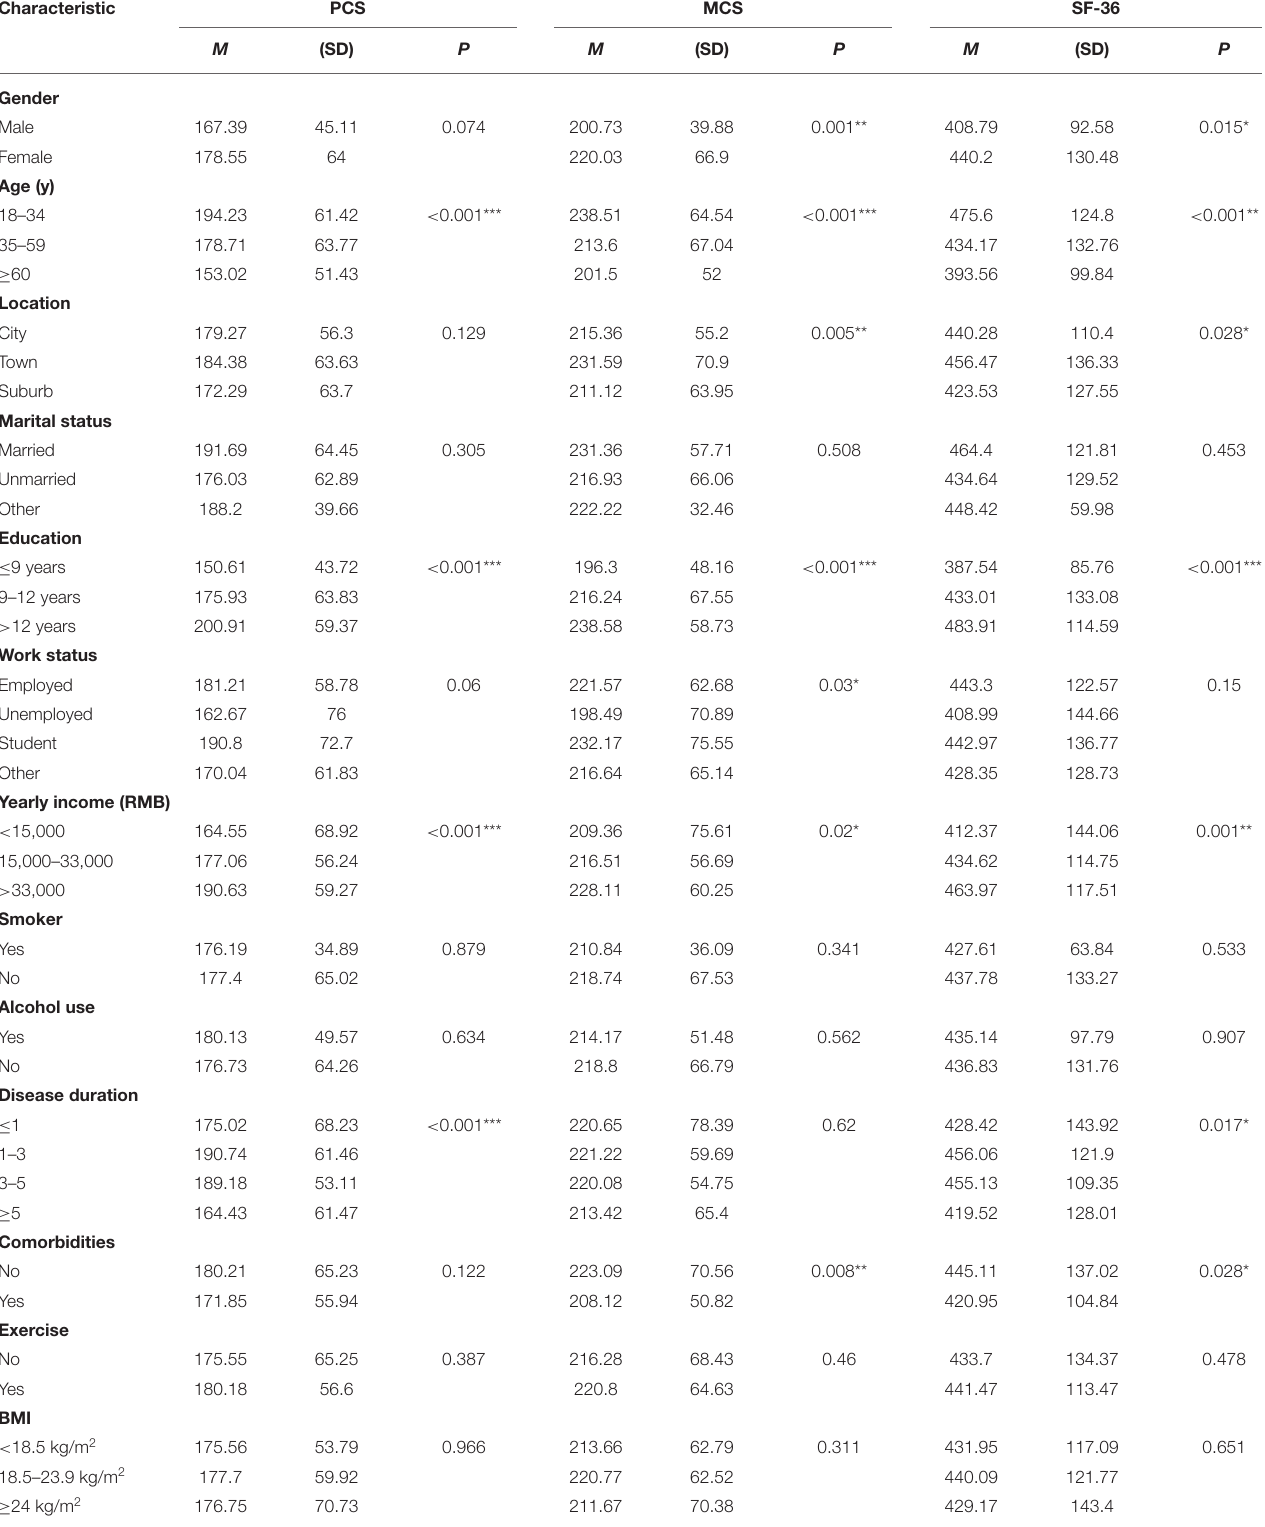
TABLE 2 | Subgroup comparisons of 36-item short form survey physical component scores, mental component scores, and total scores.